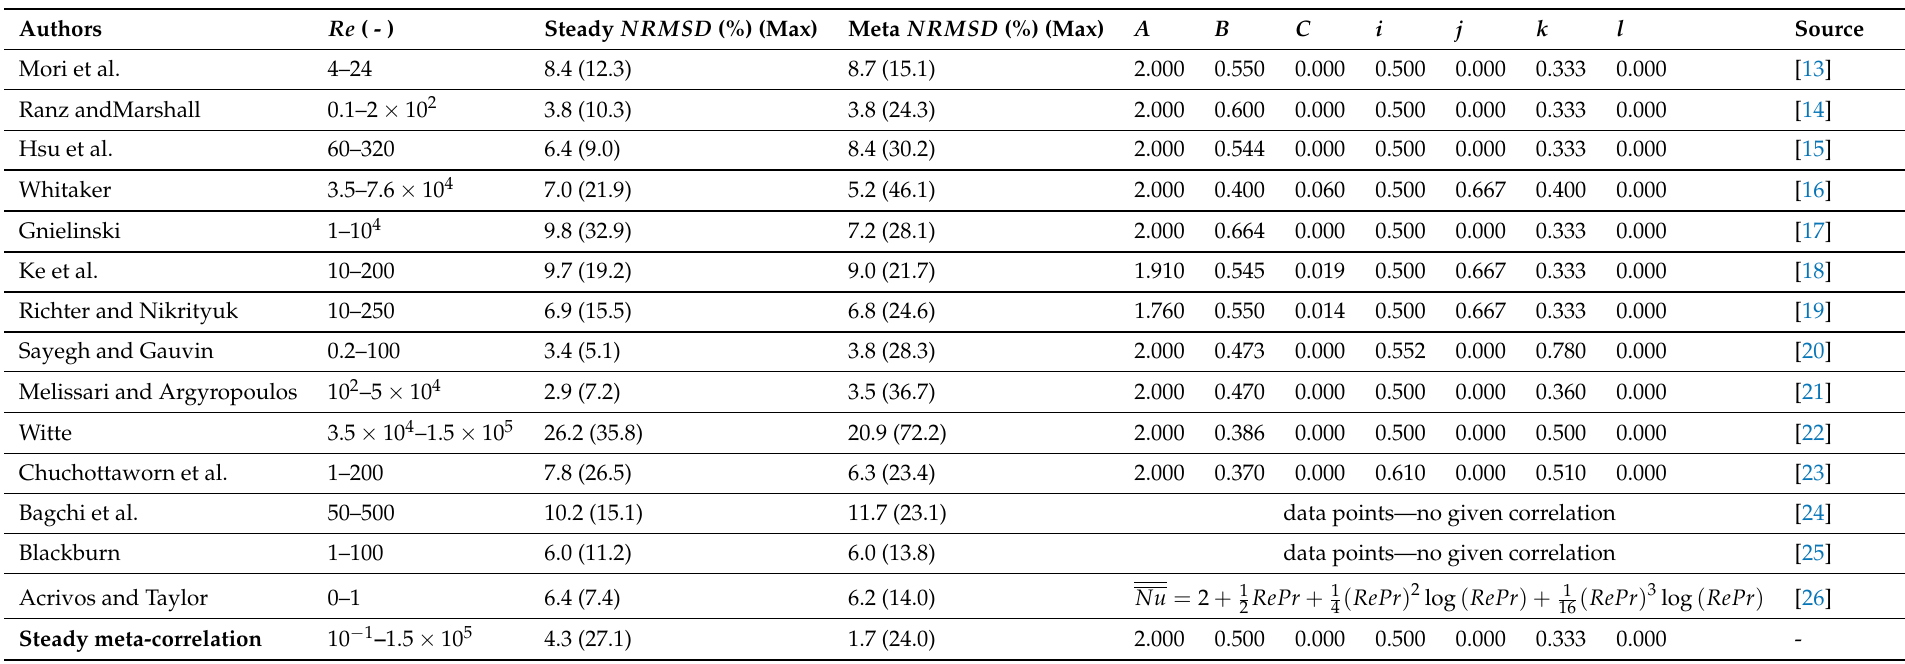
Table 1. A list of investigated works in the literature dealing with the HMT to spherical particles in steady (upper part) and oscillating flows (lower